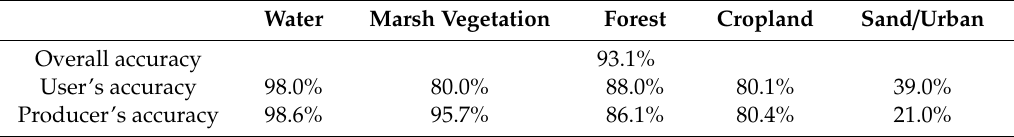
Table 3. Accuracy table for forest classification method.